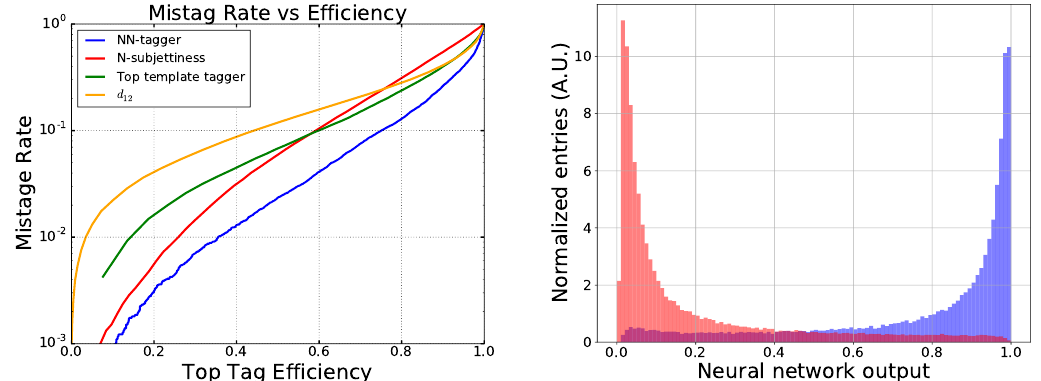
Figure 3 . Left panel: performance of CNN, compared with other variables for boosted top-jet tagging: Template Tagger [25{27] and N -subjettiness [28, 29]. Right panel: neural network output distributions for the signal and